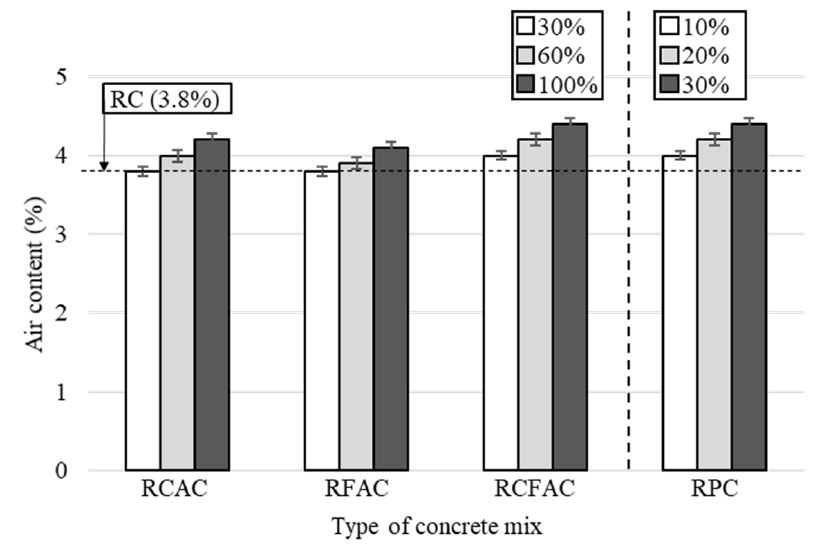
Figure 3. Air content of concrete mixes made of recycled aggregates and recycled powder.